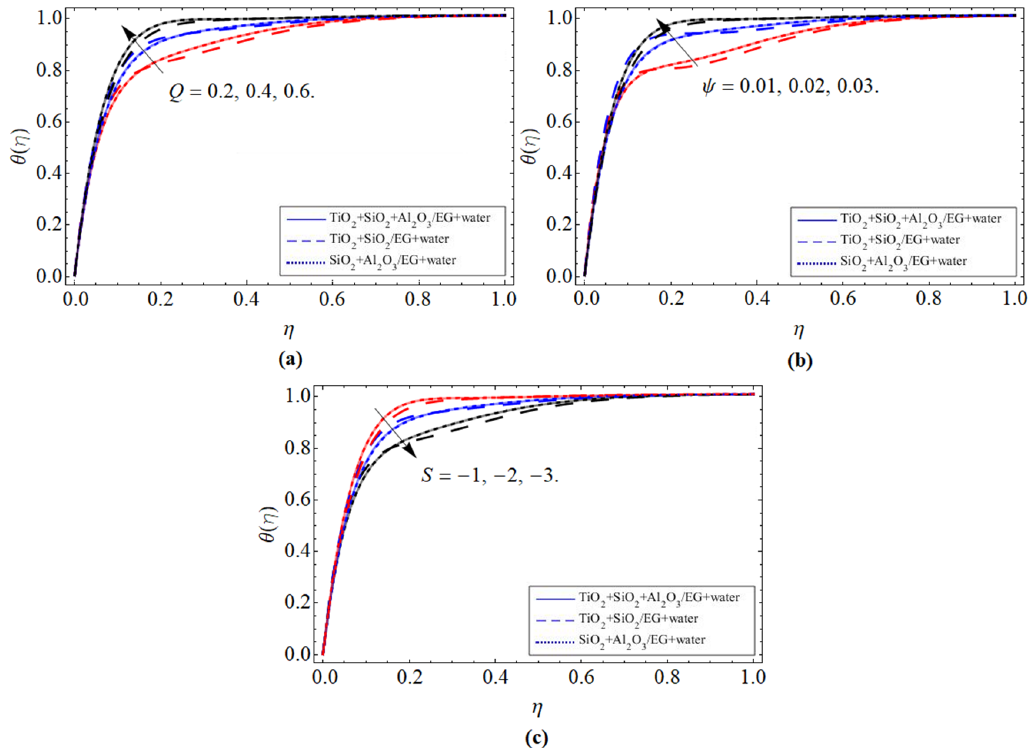
( ) θ η Figure 4. The tendency of energy profile versus ( a ) heat source Q, ( b ) volume friction of Figure 4. The tendency of energy profile θ ( η ) versus ( a ) heat source Q , ( b ) volume friction of ternary ternary nanoparticles ψ , and ( c ) injection S < 0. nanoparticles Ψ , and ( c ) injection S <